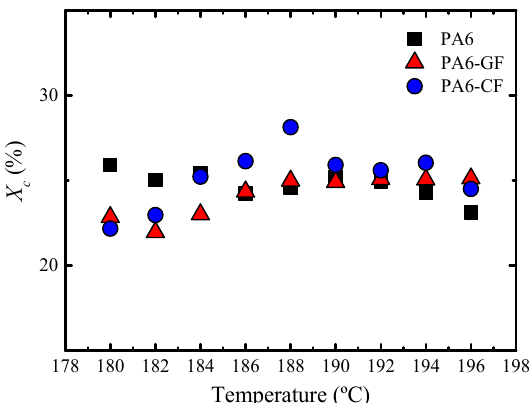
Figure 8. Relative crystallinity degree values ( X c ) as a function of T c after isothermal crystallization of PA6 and the reinforced samples.